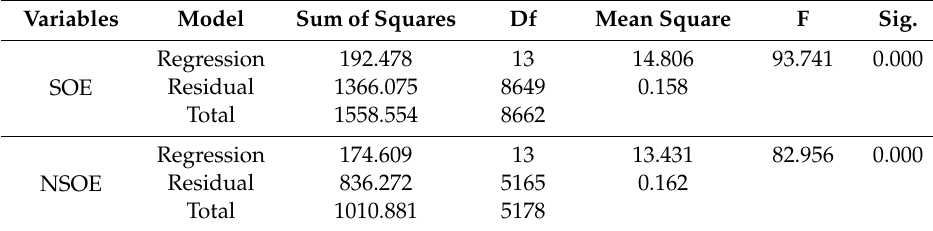
Table 4. ANOVA Results.